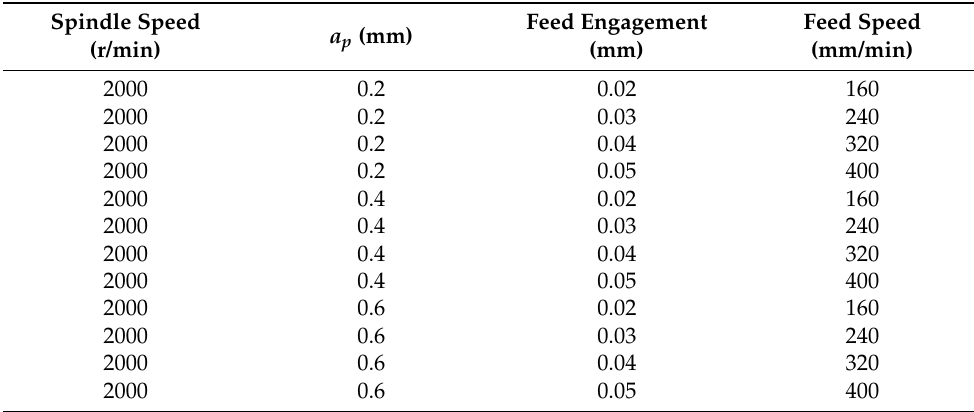
Table 4. Cutting force identification experimental cutting